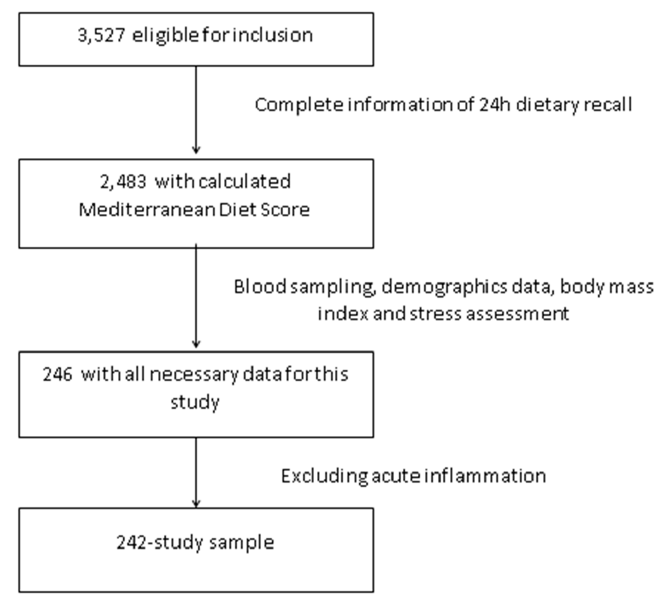
Figure 1. Flow chart of the selection procedure of the study sample among participants of Healthy Lifestyle in Europe by Nutrition in Adolescence Cross-Sectional Study (HELENA-CSS.)